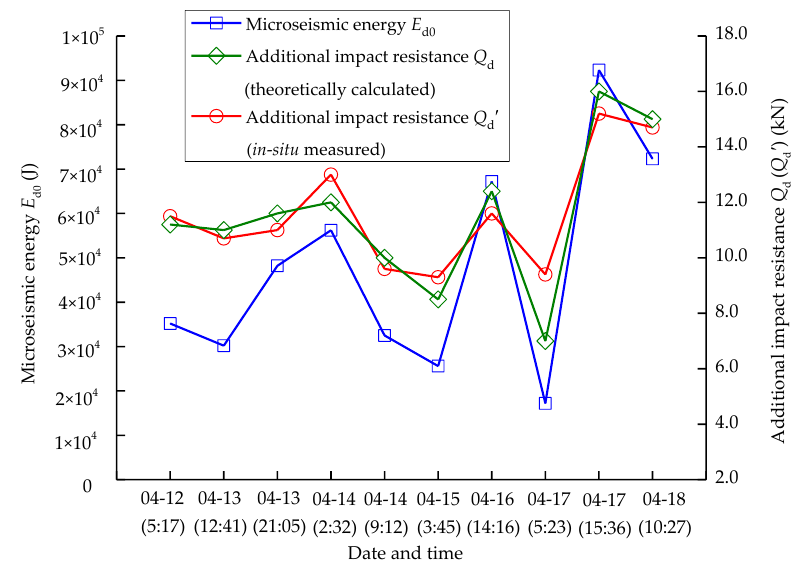
Figure 14. Distributions of microseismic energies (>10 4 J) and additional impact resistances close to the heading face of track roadway (12−18 April 2014).